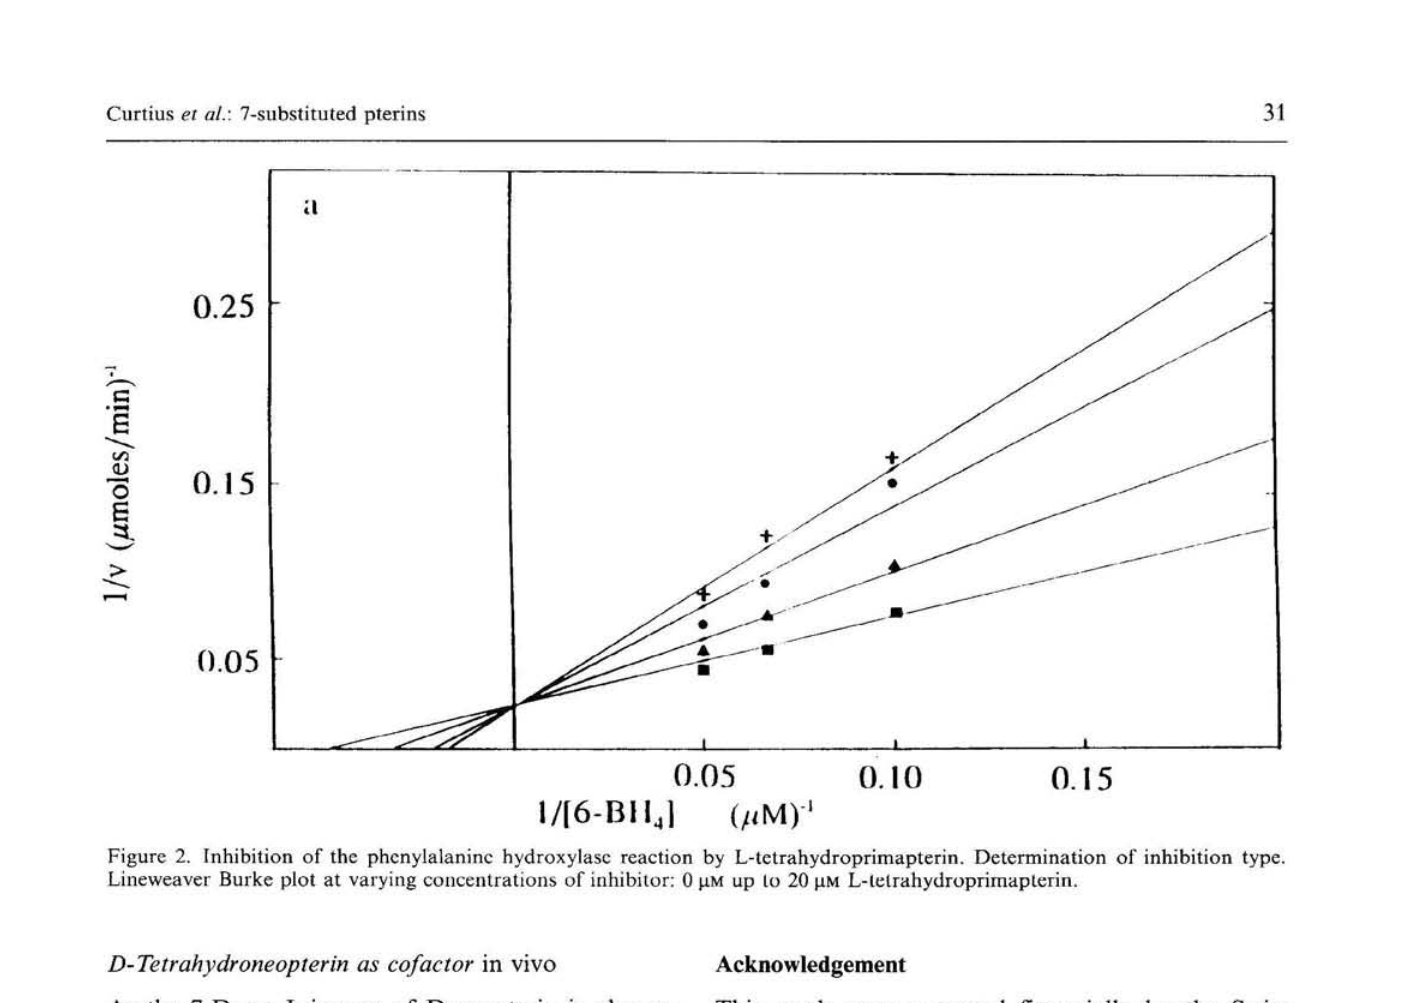
D-Tetrahydroneopterin as cofactor in